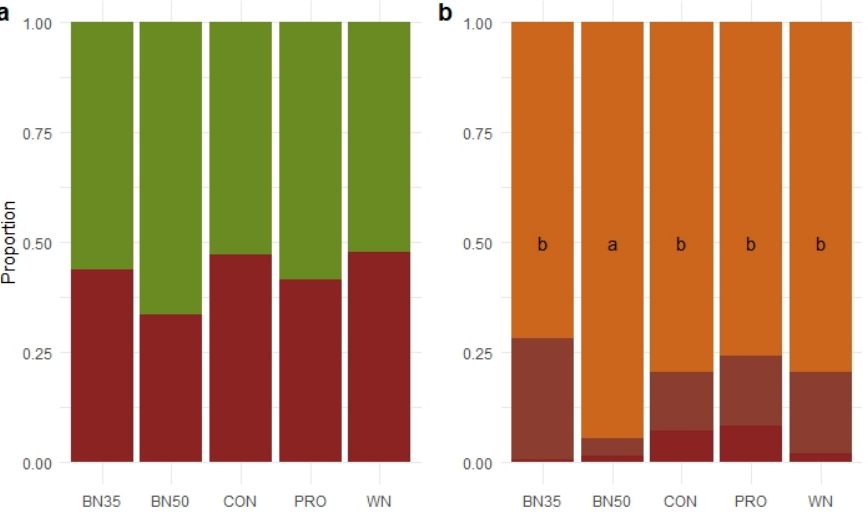
Figure 8. ( a ). Incidence of sunburn at harvest according to treatment (BN35 = Black net 35, BN50 = Black net 50, WN = White net, CON = control and PRO = protectants) SBF = sunburned fruit (brown) HF = healthy fruit (green); ( b ). severity of sunburn at harvest according to treatment (BN35 = Black net 35, BN50 = Black net 50, WN = White net, CON = control and PRO = protectants), the intensity of the color brown represents the intensity of the sunburn: Mild = slightly sunburned fruit (orange), Mod = moderately sunburned fruit (light brown), Sev = heavily sunburned fruit (brown). Bars with different letters indicate significant differences ( α = 0.05), absence of letters indicate non-significant differences.